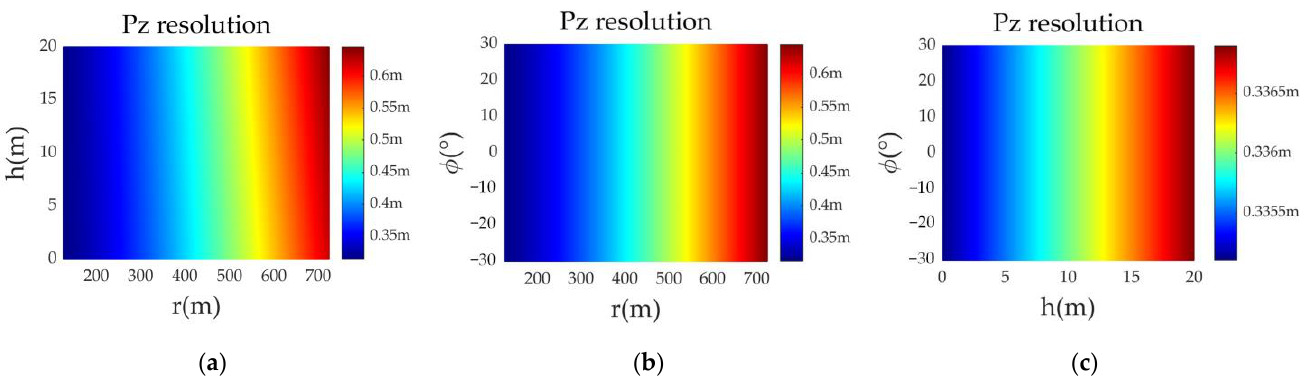
Figure 7. Height-wise resolution of targets at different positions. ( a ) the target azimuth angle is 30°; ( b ) the target height is 10 m; ( c ) the target distance is 200 m.